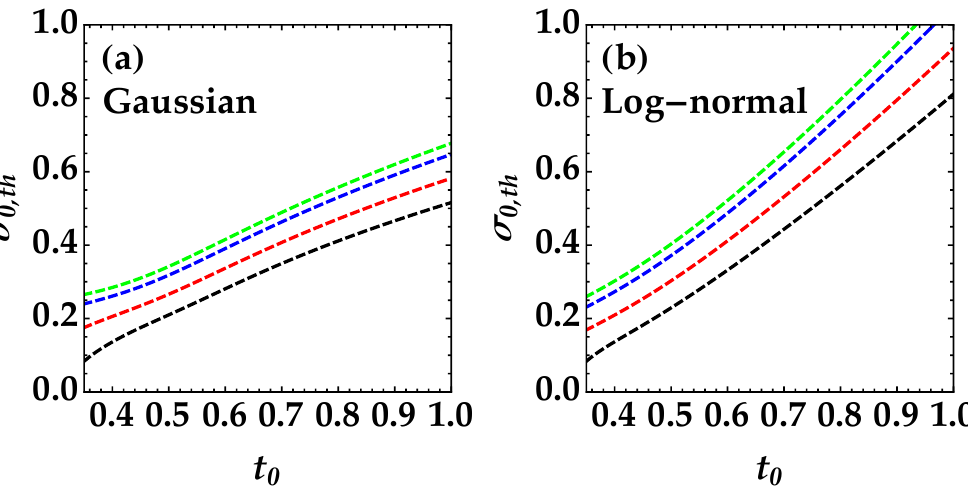
Figure 7. Expected threshold value of σ 0 obtained by setting R = 1 in Equation (4) for (cid:104) m (cid:105) = 2.23 and η = 0.145. The data are shown as a function of t 0 for different choices of m µ : 0.2 (black curve), 0.1 (red curve), 0.04 (blue curve) and 0.02 (green curve). Panel ( a ) corresponds to the case of Gaussian distributions of t 0 , while panel ( b ) to the case of log-normal